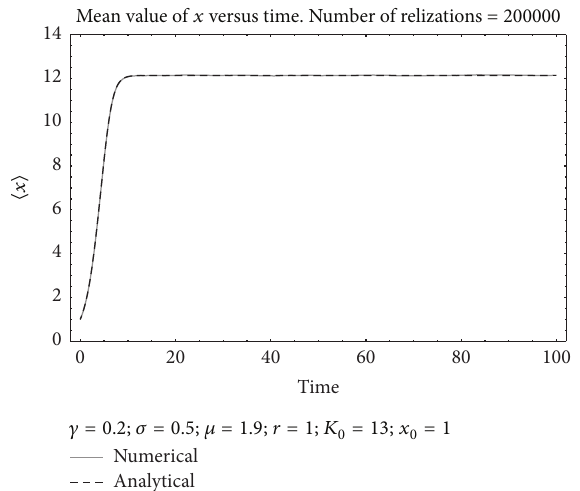
Figure 3: The plot of the mean value of 𝑥(𝑡) versus time in arbitrary units. The values of the parameters are 𝑥 0 = 0.01 , 𝛾 = 0.5 , 𝜎 = 0.9 , = 10 , and 𝑟 = 2.3 . The analytical value of ⟨𝑥(𝑡)⟩ is given 𝜇 = 1.5 , 𝐾 0 by (18). The agreement between the analytical expression (dashed line) and the numerical simulation (continuous line) is